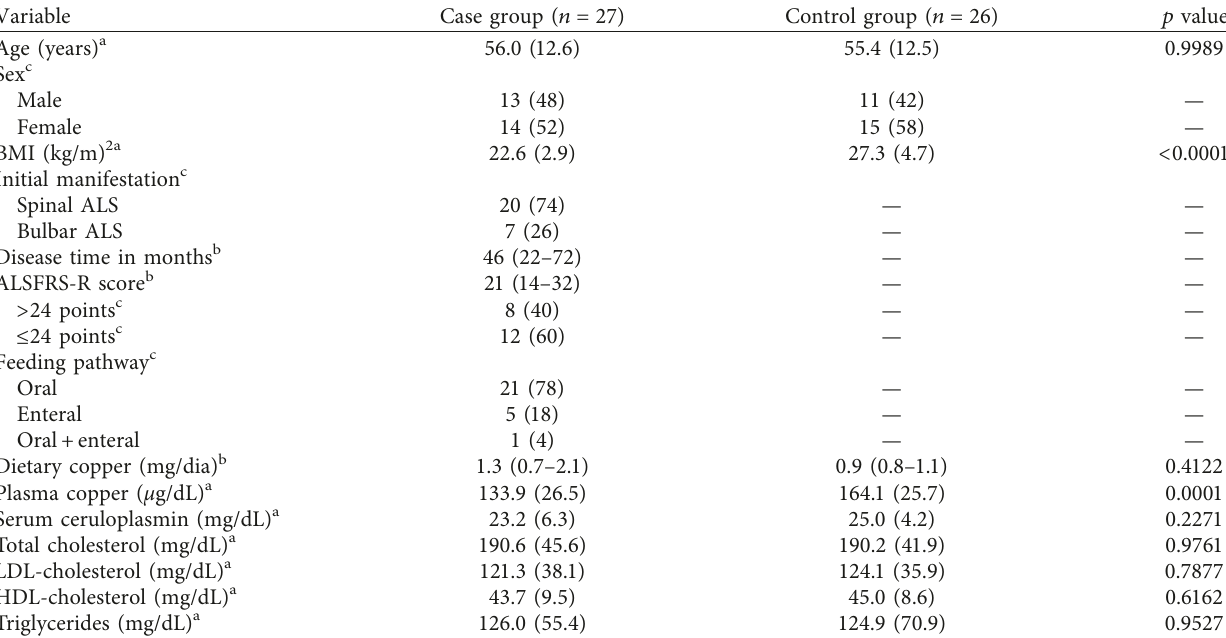
Table 1: Clinical, nutritional, and biochemical characteristics of the